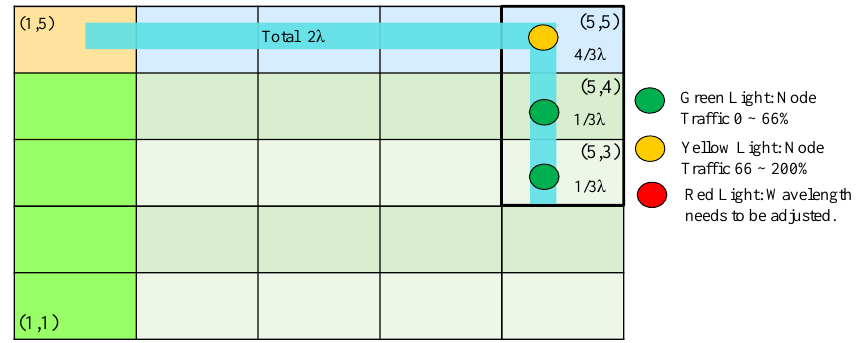
Figure 17. Traffic distribution for Method 1of two-plane optical tunnel switching network with 25 nodes.